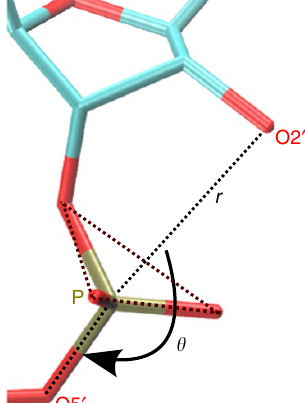
Figure 4 | An in-line configuration is required for the cleavage reaction. Preferential attack configuration in the activated precursor (AP) state as depicted schematically in Fig. 2b; y and r are the O2’ (cid:3) (cid:3) (cid:3) P (cid:3) (cid:3) (cid:3) O5’ angle and the O2’ (cid:3) (cid:3) (cid:3) P distance, respectively. For an efficient self-cleavage reaction to occur, the attacking O2’ site of A-1 should be in-line with respect to the scissile phosphate (P) and the O5’ leaving group, whereas the O2’ (cid:3) (cid:3) (cid:3) P distance should be close enough to eventually allow for the formation of the nascent O2’-P covalent